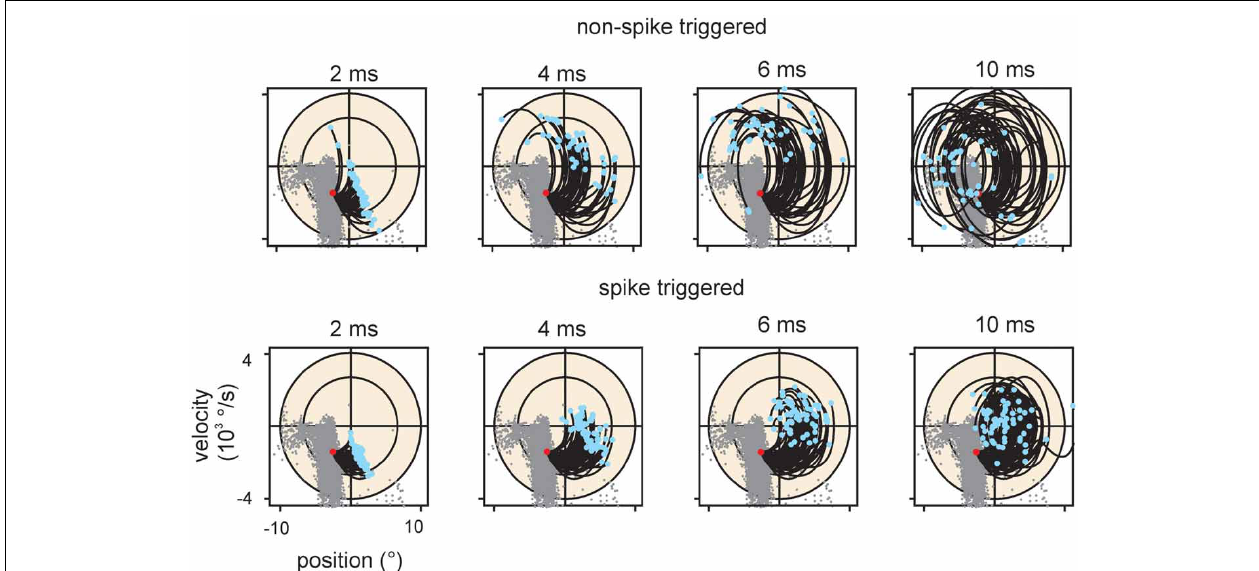
FIGURE 8 | Encoding of stimulus trajectory. The graphs plot trajectories ending at a location in stimulus space within the main lobe of cell #18. Only the 2D projection spanning position and velocity is shown for clarity. Conventions for axes and ellipsoid in spike triggered ensembles as in previous figures. Trajectory start is marked by blue dots; trajectories end at the red dots. For reference the spike triggered instantaneous stimuli are depicted as